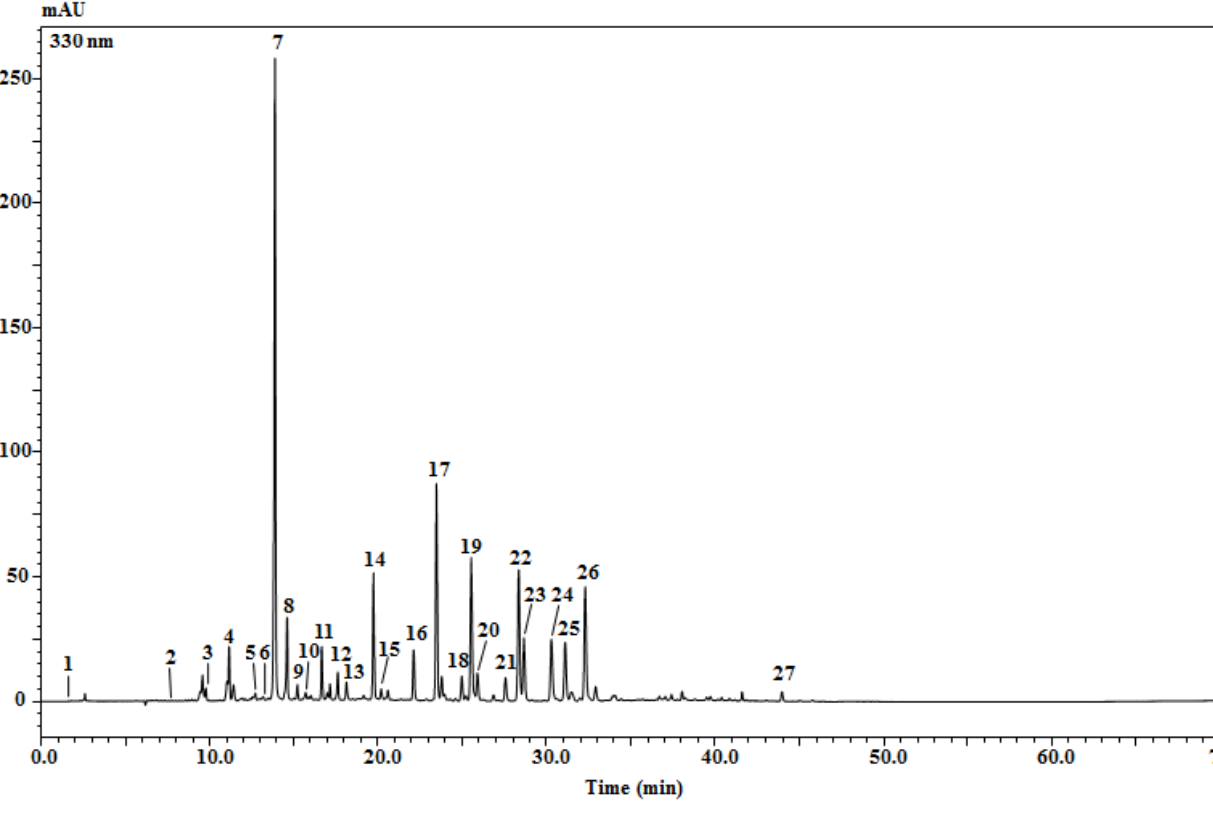
Figure 1. Chromatographic profile of phenolic compounds in Anacyclus clavatus flower extract (EtOH:H 2 O 7:3 v / v ) recorded at 330 nm. Table 2. Characterization of the phenolic composition of the Anacyclus clavatus flower extract